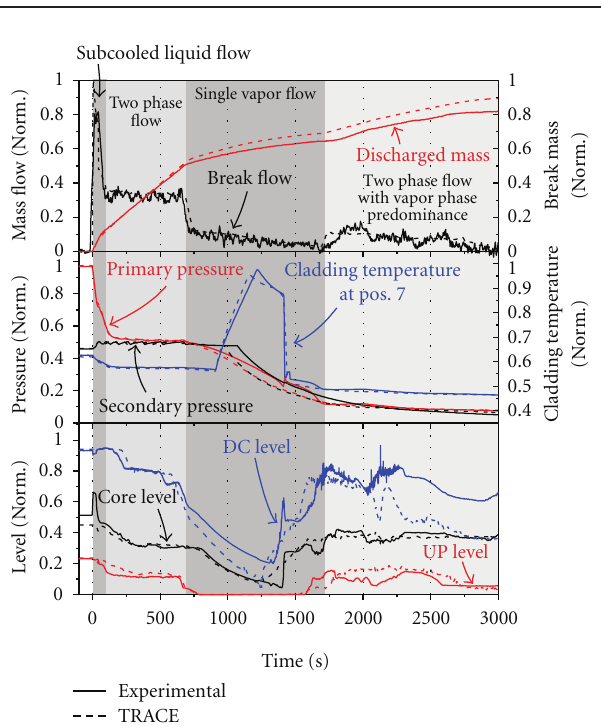
Figure 2: TRACE results for Test 6-1. From top to bottom: (1) break flow and integrated discharged mass, (2) primary and secondary pressure along with the maximum cladding temperature, and (3) RPV water